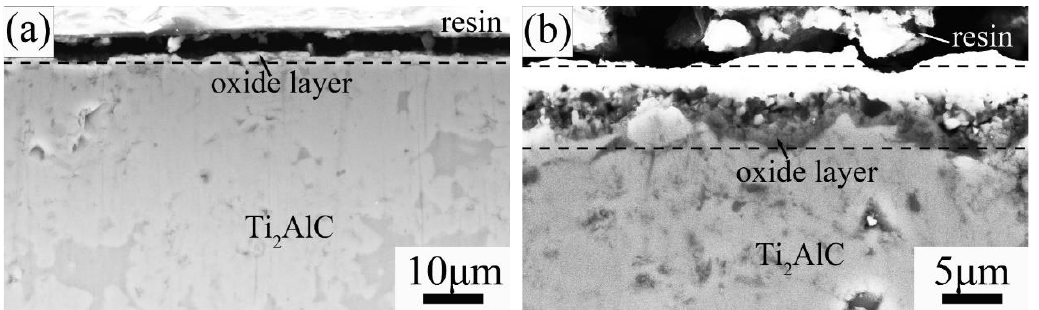
Figure 8. SEM micrographs of sample cross-section of Ti 2 AlC ceramic quenched in water at different temperatures: ( a ) 920 °C and ( b ) 1150 °C. temperatures: ( a ) 920 ◦ C and ( b ) 1150 ◦